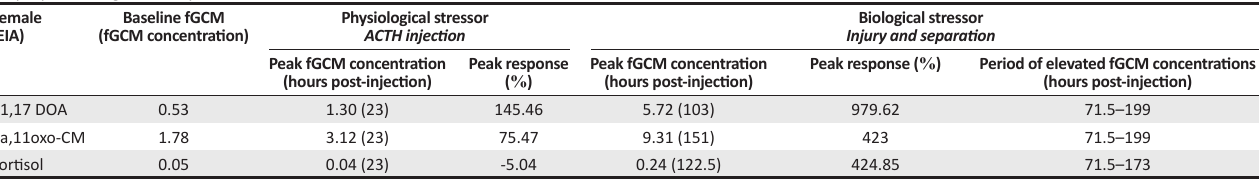
TABLE 2: Female baseline faecal glucocorticoid metabolite concentrations, as well as the mean absolute deviation from baseline, for all three enzyme immunoassays employed during the study. Female Baseline fGCM Physiological stressor (EIA) (fGCM concentration) ACTH injection